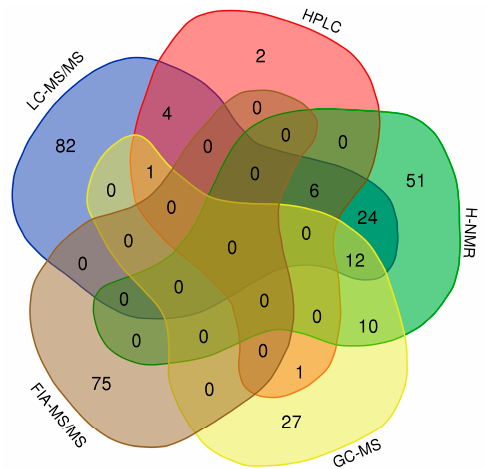
Figure 2. Venn diagram showing the overlap of urine metabolites detected by LC-MS/MS, high performance liquid chromatography (HPLC), nuclear magnetic resonance ( 1 H-NMR), gas chromatography mass spectrometry (GC-MS) and FIA-MS/MS. Experimental data: 136 compounds. Literature review: 236 data values from 78